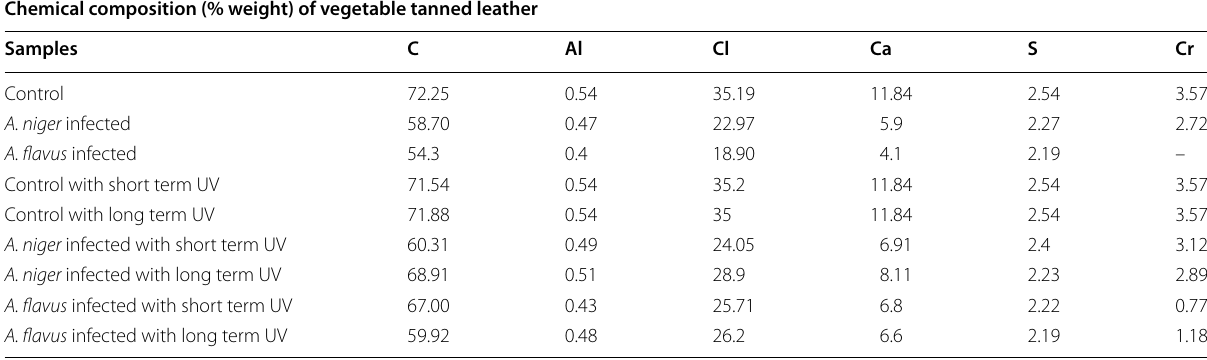
Table 3 Elemental analysis of vegetable tanned leather sample after 30 days Chemical composition (% weight) of vegetable tanned leather Samples